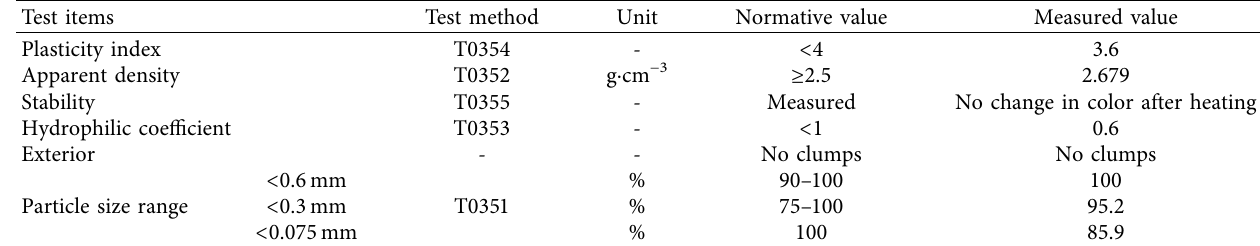
Table 4: Properties of mineral powder.